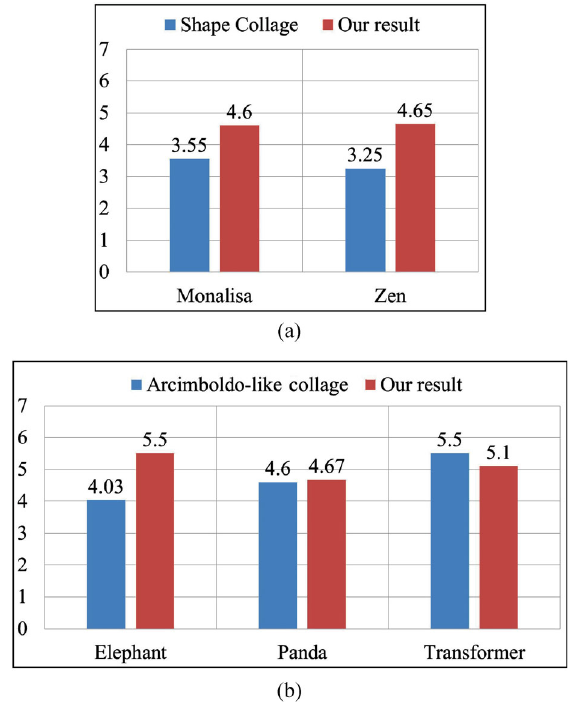
Fig. 9 Average scores of the results of the three methods in the user